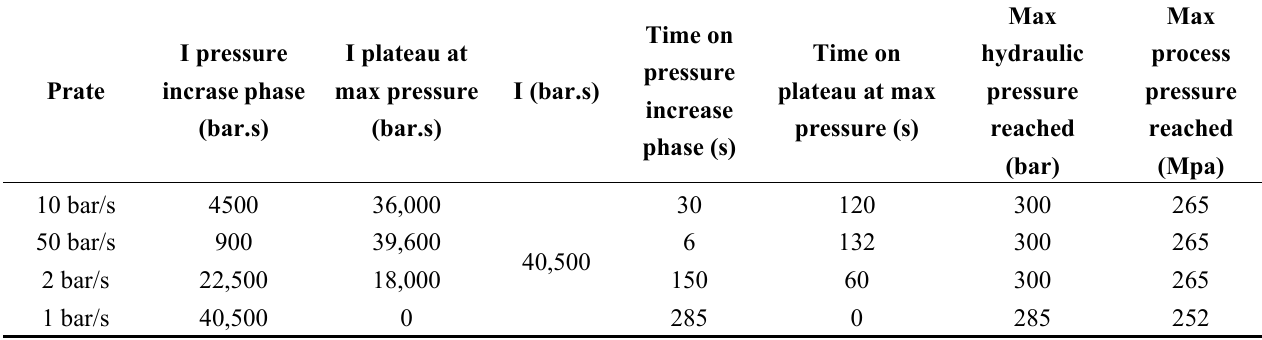
Table 3. Time, Pressure and cycle of the Pressure rate increase series of experiments.